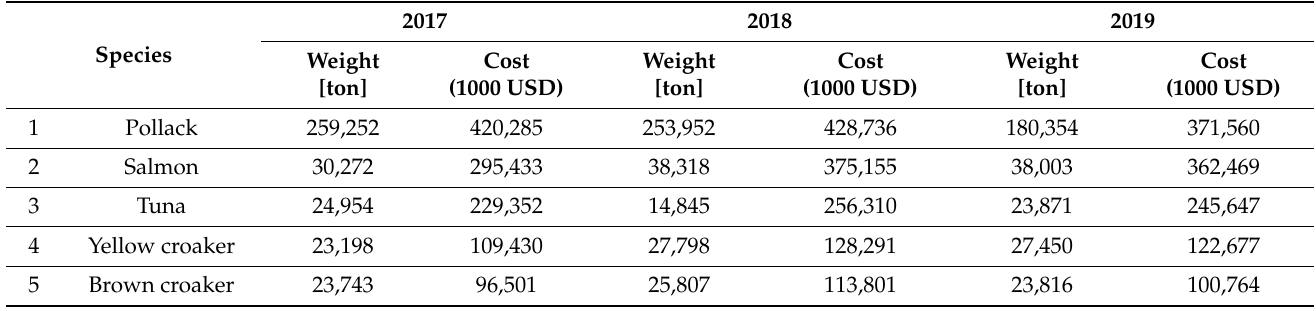
Table 4. Annual import of fish from 2017 to 2019 in South Korea